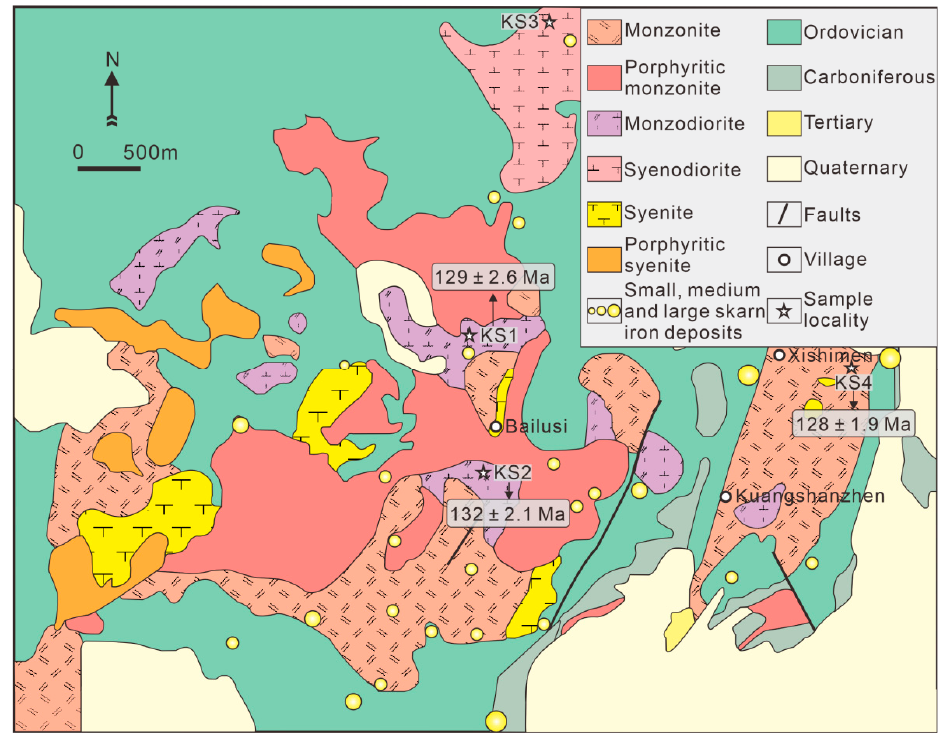
Figure 3. Geological map of the Kuangshan complex (modi fi ed after [64]). Age data are from [58].